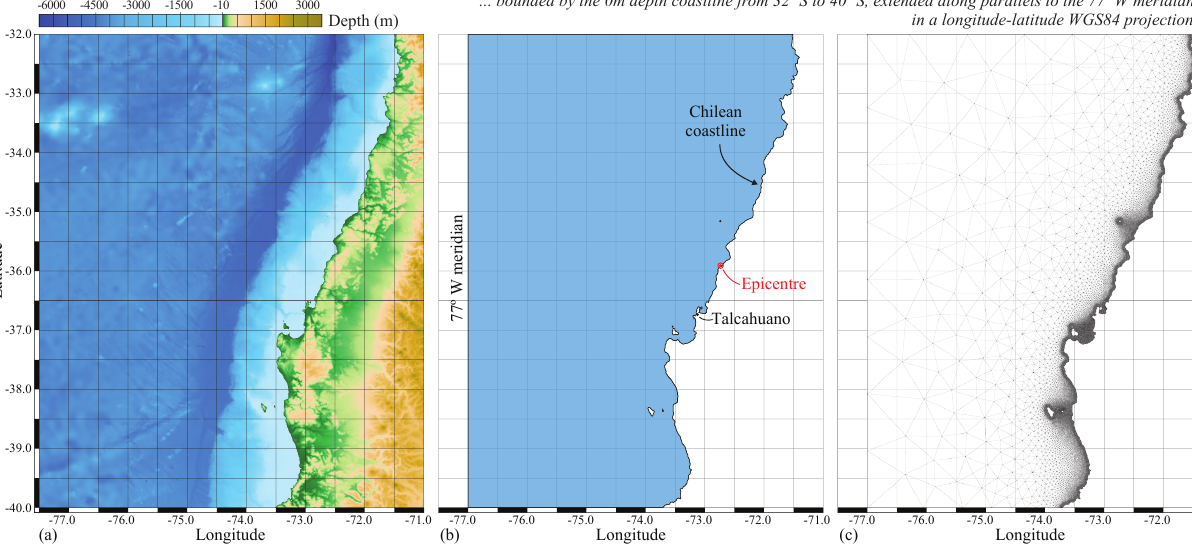
Figure 7. Example simulation domain for modelling ocean wave propagation and tsunami inundation in the 2010 Chile M 8 . 8 earthquake, centred at 35.9 ◦ S, 72.7 ◦ W, approximately 100km north of Talcahuano. This domain is relatively simply described by ( ∗ ) in Sect. 1 with constraints formally defined by the BRML of Fig. 5 (with some further description and a corresponding formal BRML to constrain spatial resolution). Generation is a simple matter of translating the former into the latter under the formal grammar, with both being human-readable descriptions. Shingle automatically handles the details of defining a high-fidelity boundary representation (cid:48) (cid:48) in (b) from the GEBCO (2014)